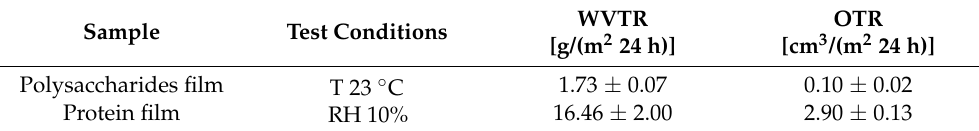
Table 2. Barrier properties of films, the results are reported as the mean ± sd.